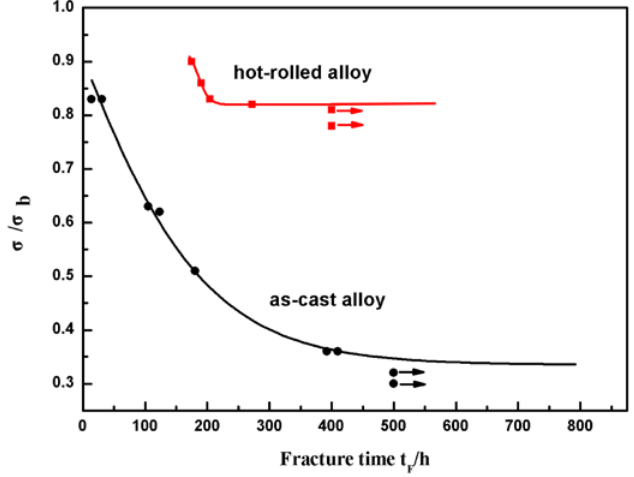
Figure 5. Fracture time t F vs. normalized stress σ / σ b for two states of Fe 85 Ga 15 alloys in the 3.5 wt % NaCl solution.